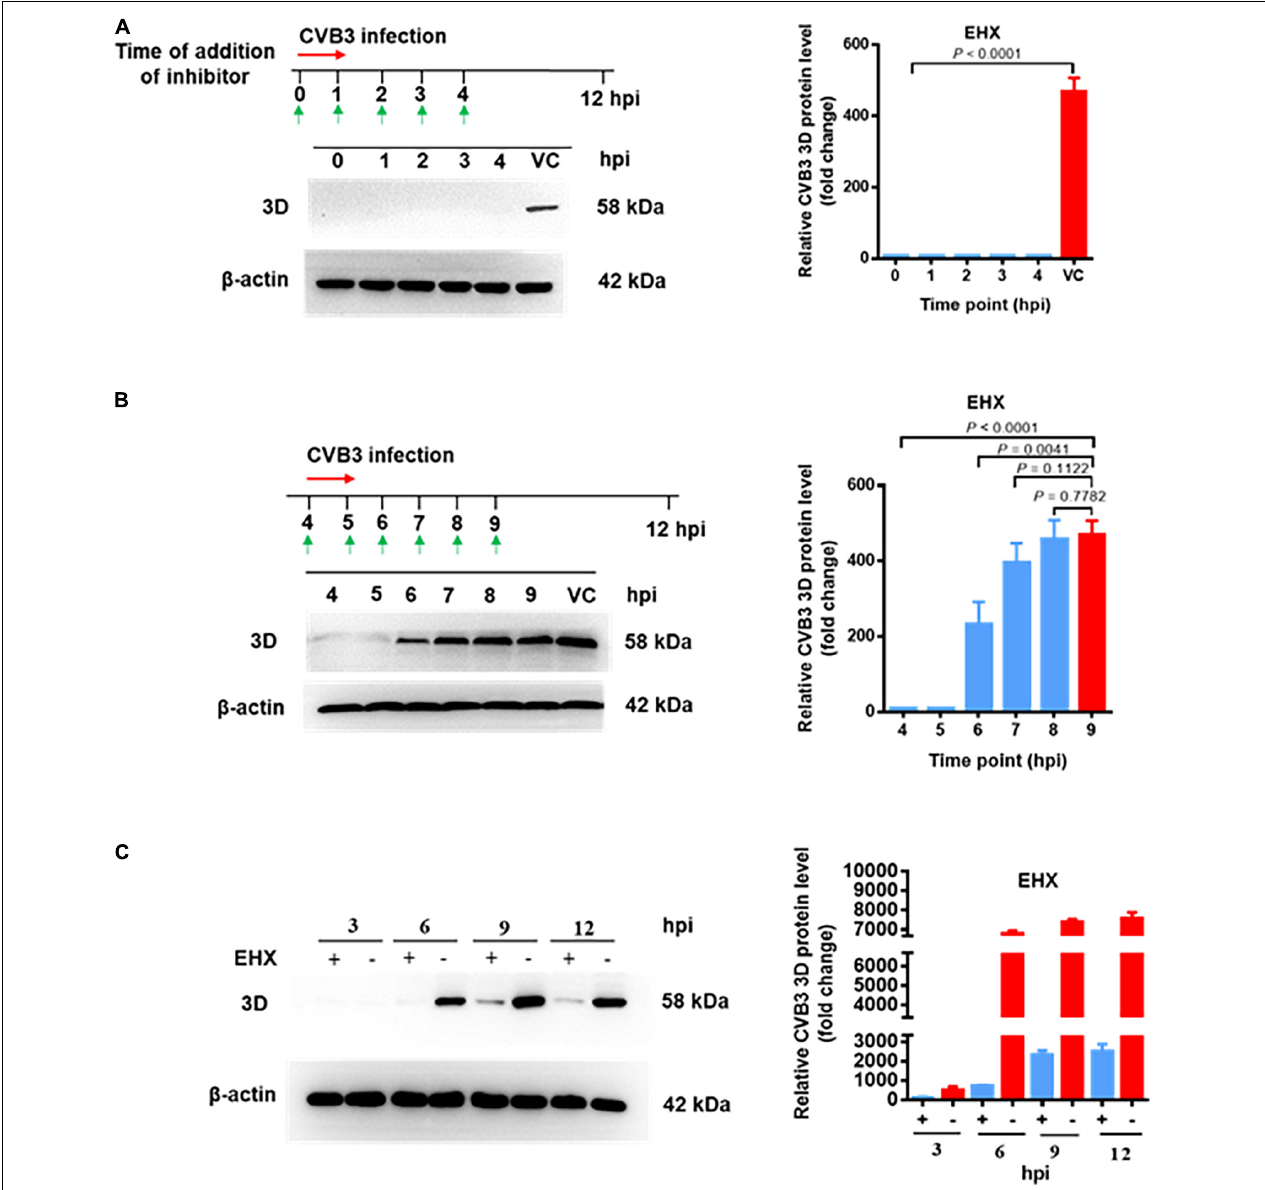
FIGURE 5 | EHX inhibits CVB at the early stage of replication. (A,B) Time-of-addition assay. HeLa cells were infected with CVB3 (MOI = 1) and were treated with EHX (8 µ M) at the indicated time points. Total protein was extracted and analyzed using Western blotting at 12 hpi. (C) CVB replication cycle. HeLa cells were infected with CVB3 (MOI = 1) and cultured in medium supplemented with EHX (8 µ M). Total proteins were extracted at the indicated time points and analyzed using Western